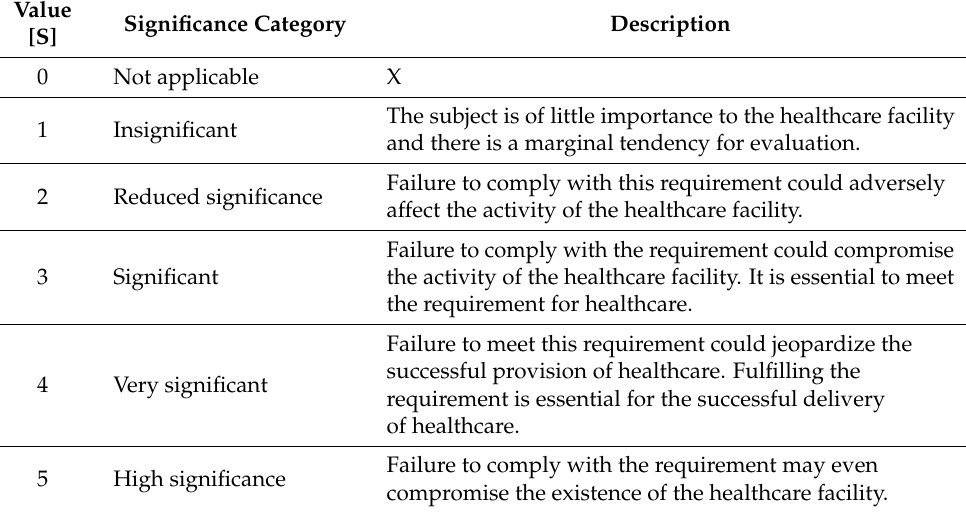
Table 2. Significance of the